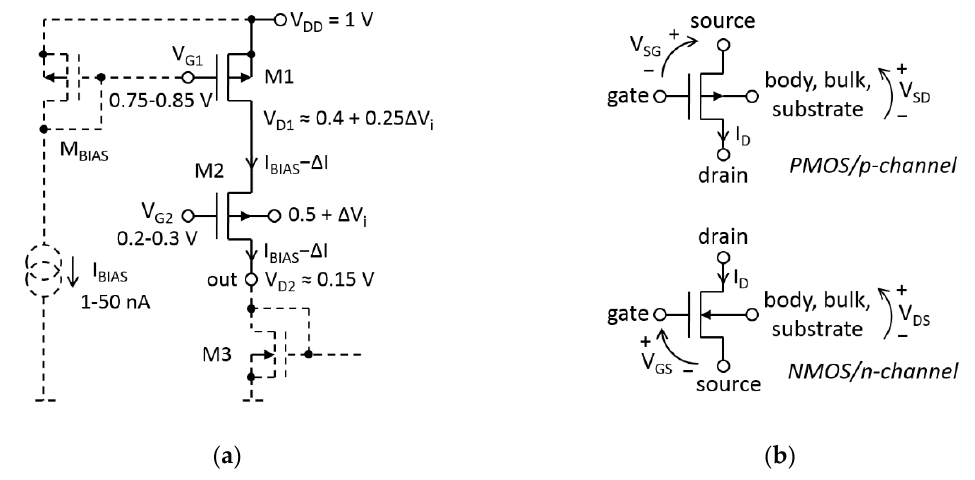
Figure 2. A voltage-to-low-current conversion utilizing the channel-length-modulation effect in MOSFET: ( a ) the realization in CMOS technology; ( b ) MOSFET’s notation. The input signal is ∆V i and the output signal is ∆I . Here, saturation of all transistors is assumed. The transistor M 1 is a DC current source that is generating the bias current I BIAS . M 2 is a bulk-driven